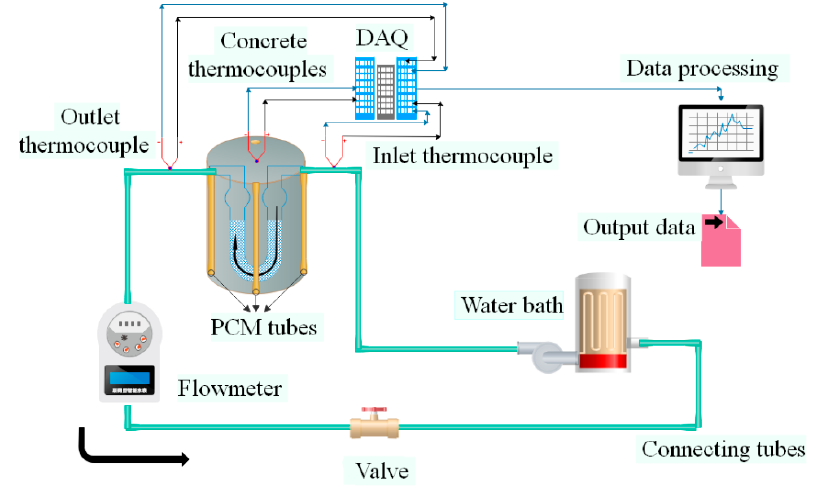
Figure 2. Schematic diagram of the third sample .